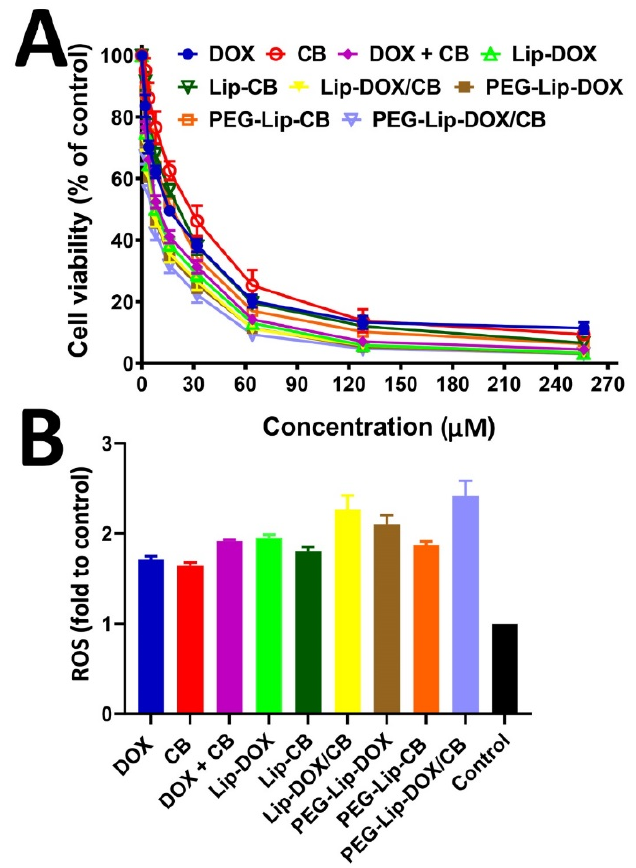
Figure 3. ( A ) Cell viability effects of DOX, CB, Lip-DOX, Lip-CB, Lip-DOX/CB, PEG-Lip-DOX, PEG- Lip-CB, and PEG-Lip-DOX/CB against rat glioma C6 cells, measured by MTT assay. ( B ) Intracellular generation of reactive oxygen species (ROS) in C6 cells after incubation with DOX, CB, DOX + CB, Lip-DOX, Lip-CB, Lip-DOX/CB, PEG-Lip-DOX, PEG-Lip-CB, and PEG-Lip-DOX/CB. Incubating C6 cells with the formations caused cell damage by producing intracellular ROS and oxidative stress. PEG-Lip-DOX, PEG-Lip-CB, and PEG-Lip-DOX/CB, compared to Lip-DOX, Lip-CB, and Lip-DOX/CB, were more potent in producing intracellular ROS. In addition, DOX + CB, compared to DOX and CB, was more potent in producing intracellular ROS, indicating the synergy between the drugs. The data are expressed as mean ± SD ( n =